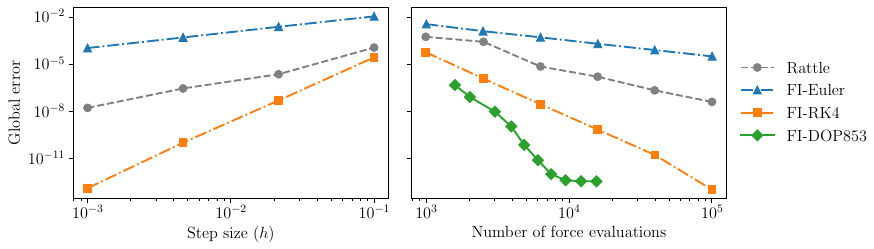
Figure 6. Left: The global trajectory error after one period of the pendulum (approximately 7.4 time units) as a function of the step size (DOP853 is not included as it is a variable step size method). As the step size decreases, the global error decreases at a rate proportional to the error of the method. Right: The global error, but now as a function of the computational budget (number of force evaluations). Larger computational budgets correspond to smaller step sizes and, hence, lower errors, but take into account the fact that the feedback methods involve more force evaluations. Despite the overhead, feedback integrators are able to do at least as well as, or better than,